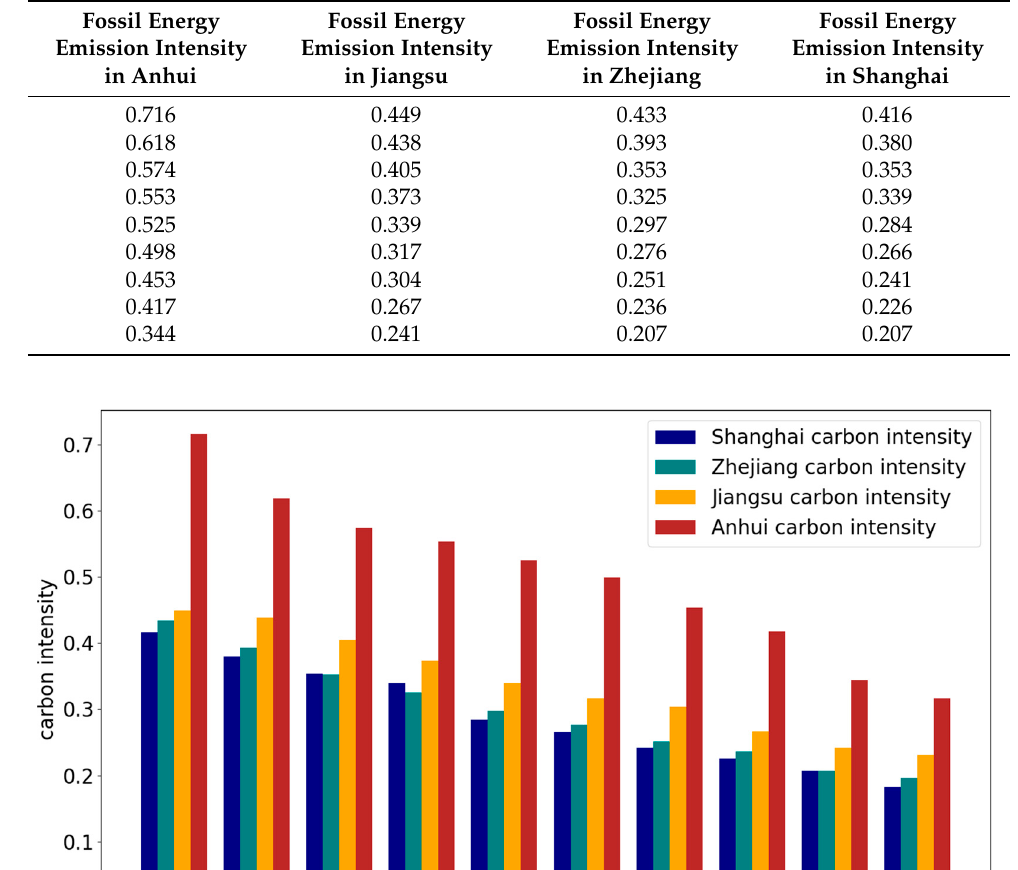
Table 3. Carbon emission intensity of three provinces and one city in the YRD Region from 2010 to 2019.